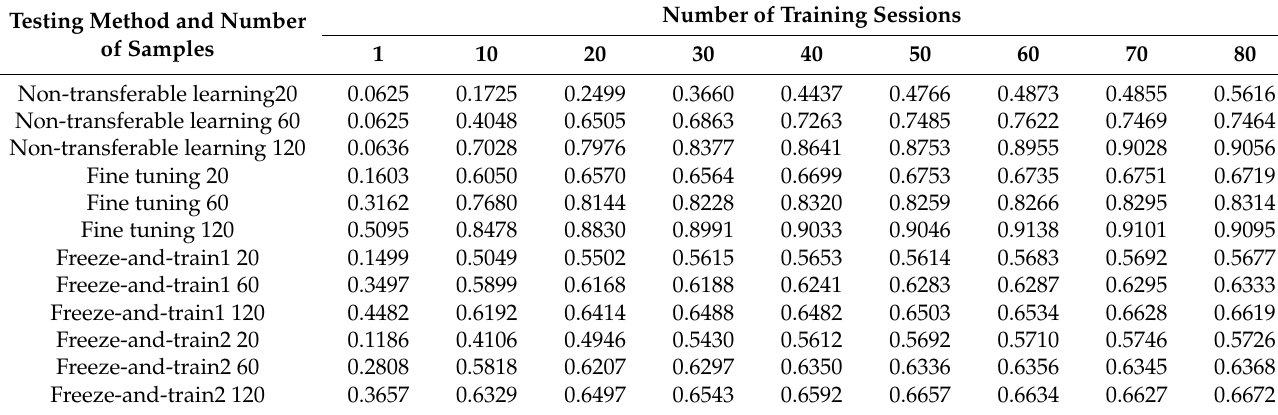
Table 9. Effect of using two fully connected